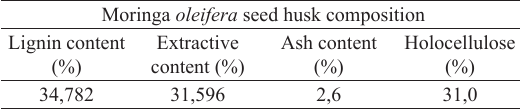
Table 3. Moringa oleifera seed husk composition.